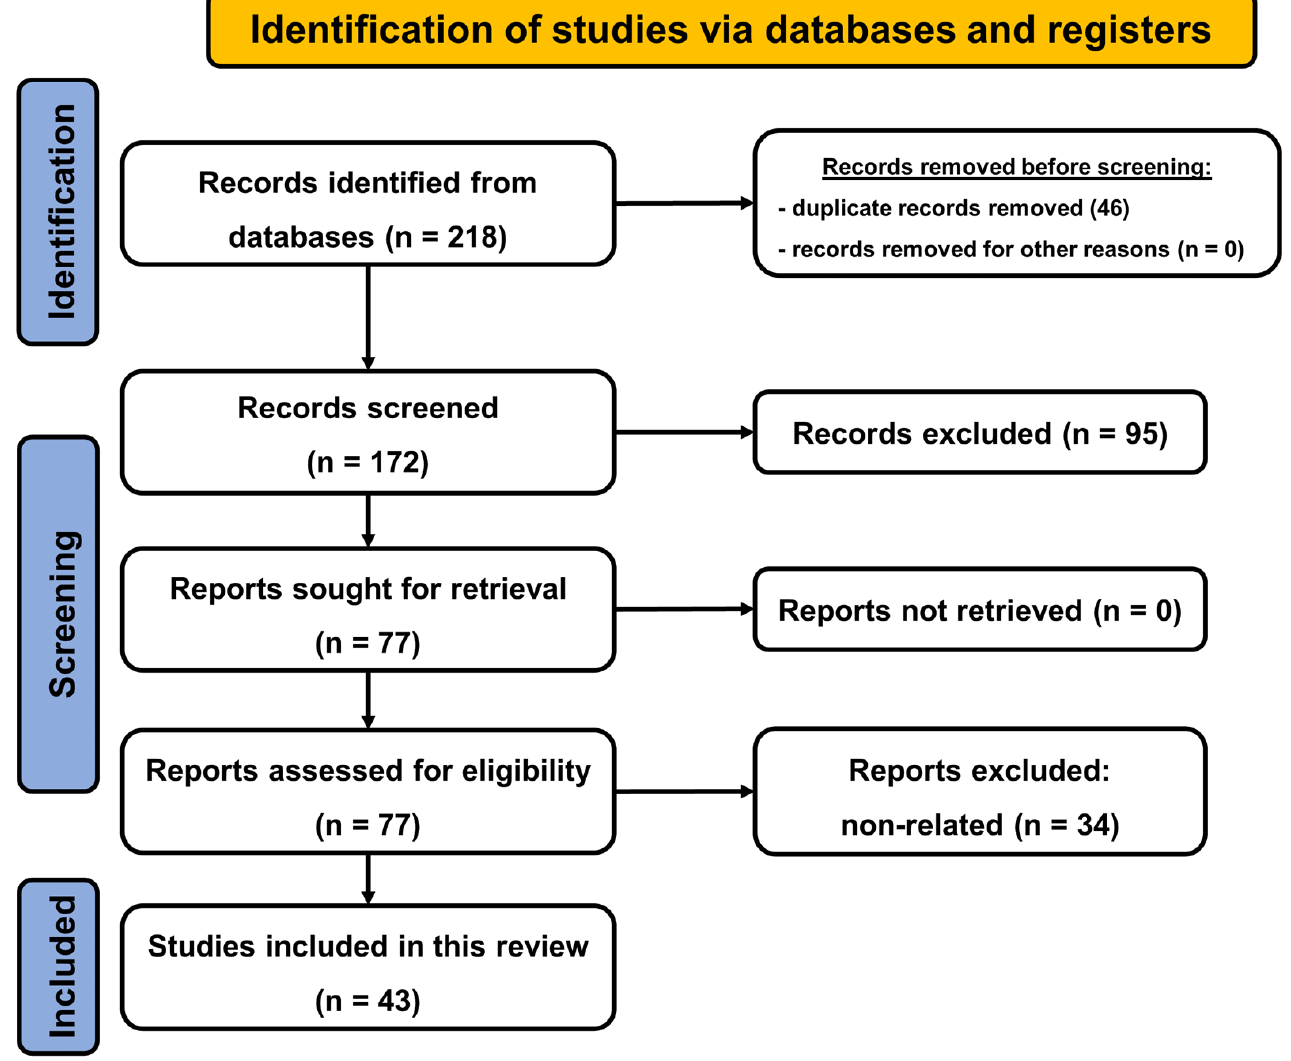
Figure 1. The PRISMA Flow Diagram.